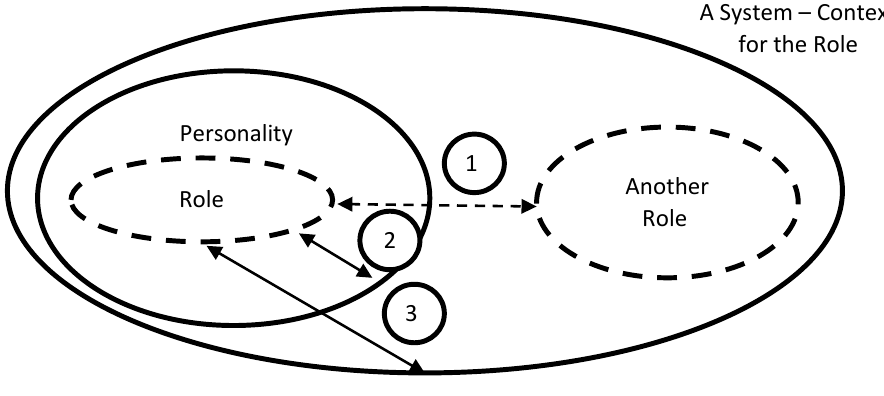
Figure 2. Three types of role